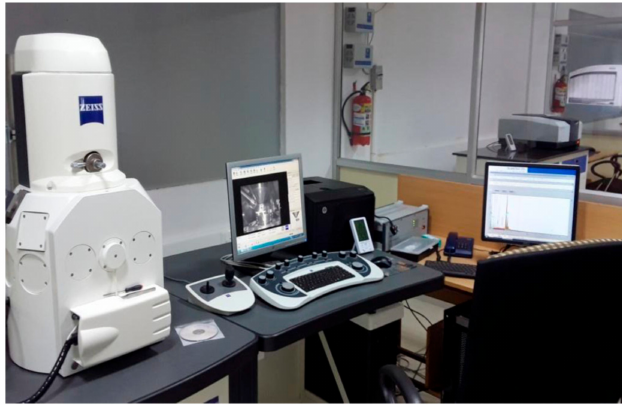
Figure 15. Scanning Electron Microscope.